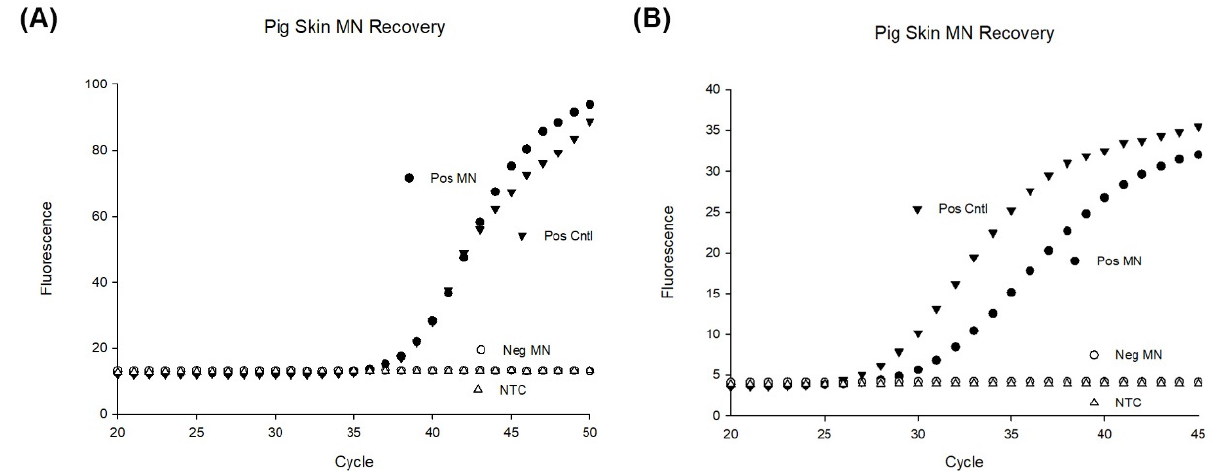
Figure 9. PCR results of MN patches applied to porcine ear skin. ( A ) 10 3 bacteria were deposited to the depth of 300 µ m and four MN were applied to the location for 10 min and subsequently dissolved in 50 µ L of TE buffer for PCR (n = 4). A positive control was made by pipetting 10 3 bacteria into 50 µ L of TE buffer (n = 4). As a negative control, four microneedle patches were applied to porcine ear skin for 10 min and dissolved in 50 µ L of TE buffer before PCR (n = 4). ( B ) 10 4 bacteria were deposited to the depth of 300 µ m and four MN were applied to the location for 10 min and subsequently dissolved in 50 µ L of TE buffer for PCR (n = 4). A positive control was made by pipetting 10 4 bacteria into 50 µ L of TE buffer (n = 4). As a negative control, four microneedle patches were applied to porcine ear skin for 10 min and dissolved in 50 µ L of TE buffer before PCR (n =